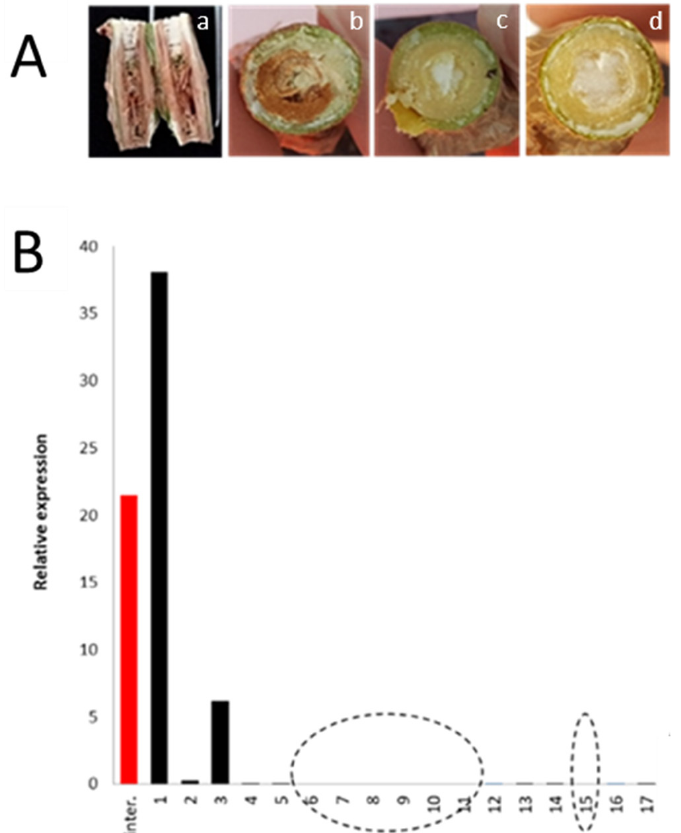
Figure 1. CBSV symptoms and virus quantification in stem sections of a DSC 167 branch from the chimeric TMS 96/0304-DSC 167. ( A ) Necrosis in DSC 167 was only found at the graft intersections where virus was readily detected ( a , b ), but not in regions of the stems distant from the graft junction ( c , d ). ( B ) Virus detection by TaqMan qRT-PCR in single slices of sections taken from a DSC167 branch starting at the graft intersection up to the top, at 1 cm intervals. Open circles mark samples (branch areas) where the assay was negative. Overall, DSC 167 branches of 4 plants were individually tested, with negative-assay results dispersed over the length of the branch.